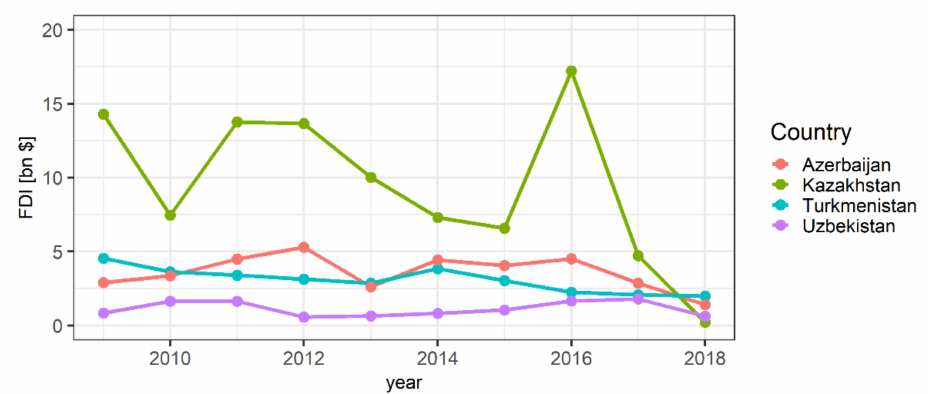
Figure 3. FDI inflows in selected countries (2009–2018). Source: [69,70].